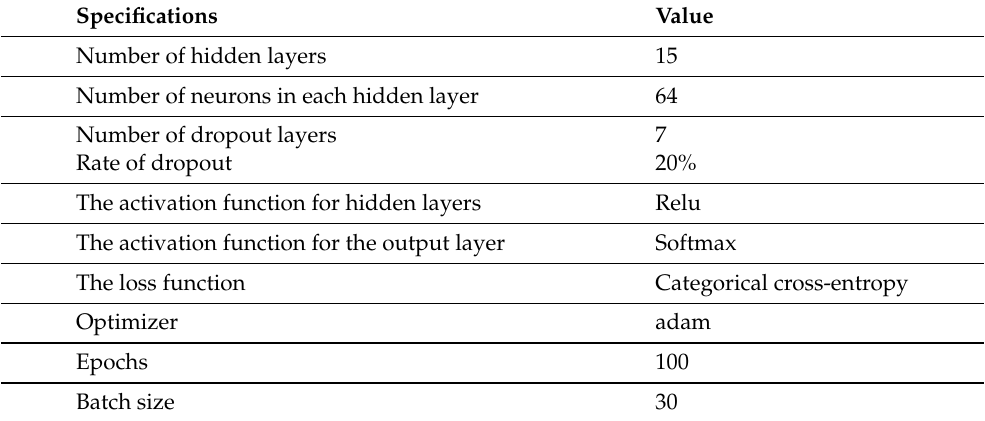
Table 5. MLP model